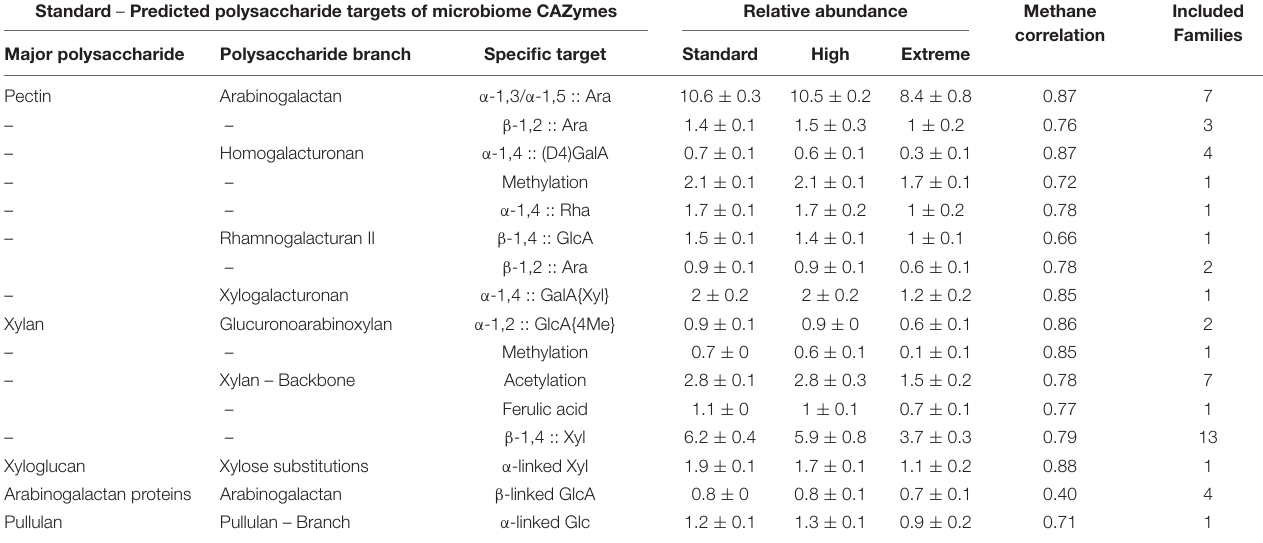
TABLE 5 | Significantly changed substrate linkage targets between the Standard group and the Extreme group across all bins, which are most abundant in the Standard